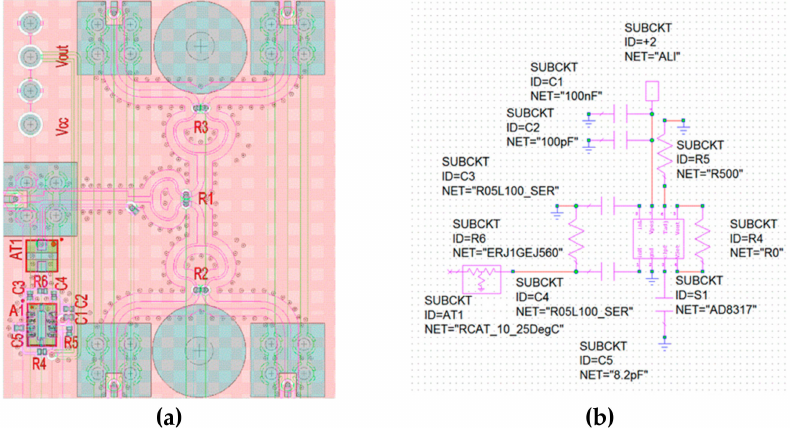
Figure 10. ( a ) Design of four-way local oscillator splitter for the 2.950–8.575 GHz band. The LO input is on the left. The outputs are arranged symmetrically: two are on the top, two on the bottom; ( b ) Schematic circuit of the LO power